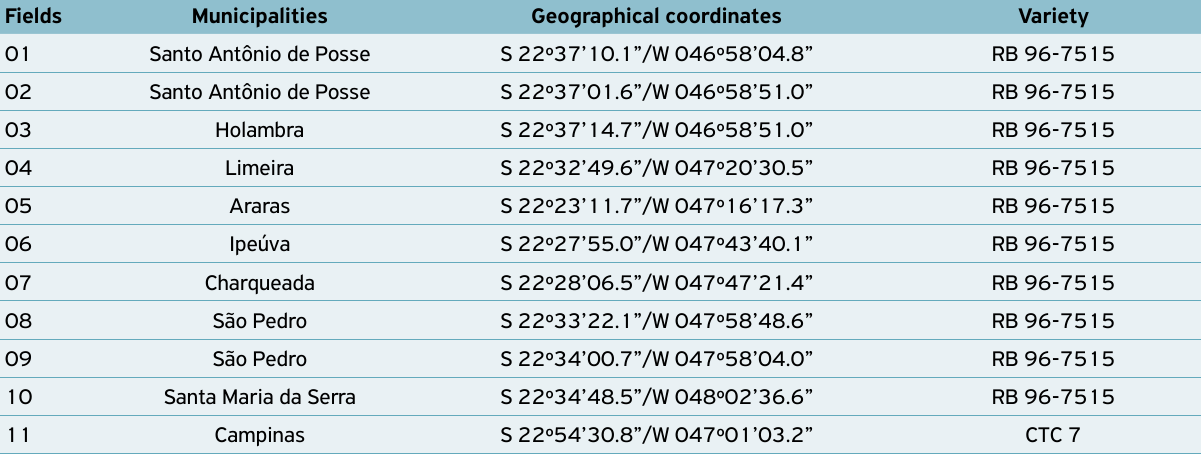
Table 1. Fields, cities, geographical coordinates and varieties of 11 fields of sugarcane, in nine municipalities of São Paulo state, where samples were taken to isolate Bacillus strains.